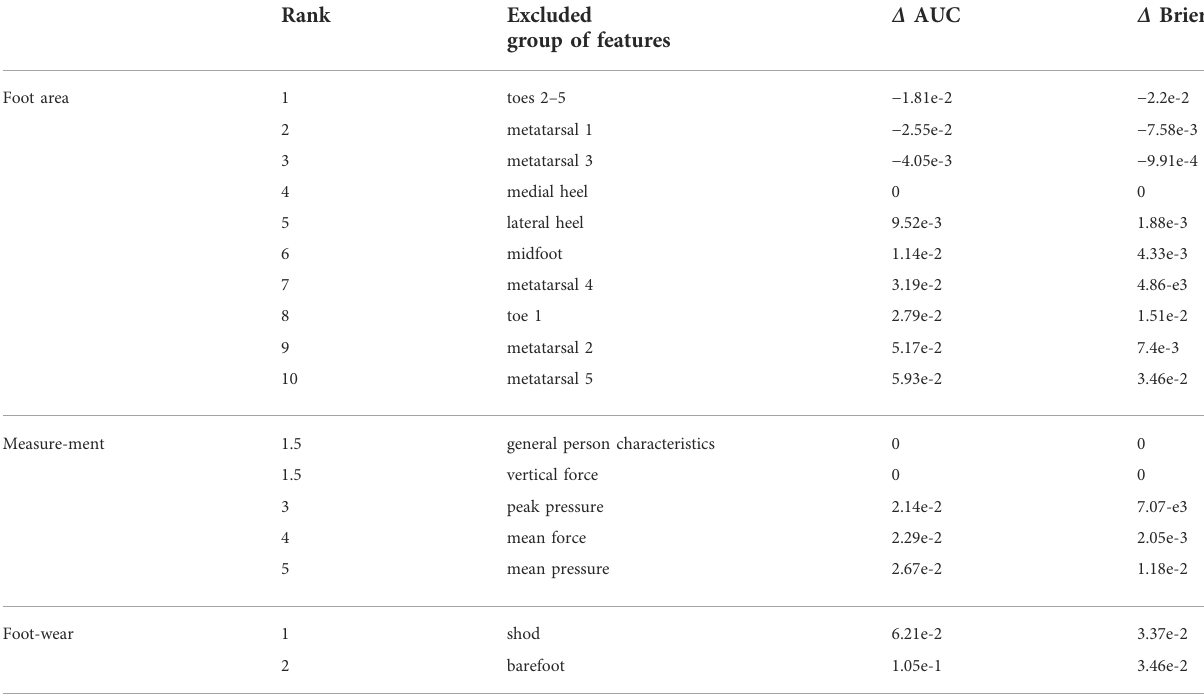
TABLE 3 The ranking and the improvements in the AUC and Brier scores for each foot area, measurement type and footwear when 15 features are selected by SelectKBest .Alowerrank indicates amore important groupof features. Δ refers tothe improvement inthe corresponding score with respect to the model that has access to all features, where a positive improvement means that the model where the current group of features was excluded performed better than the model that had access to all features.